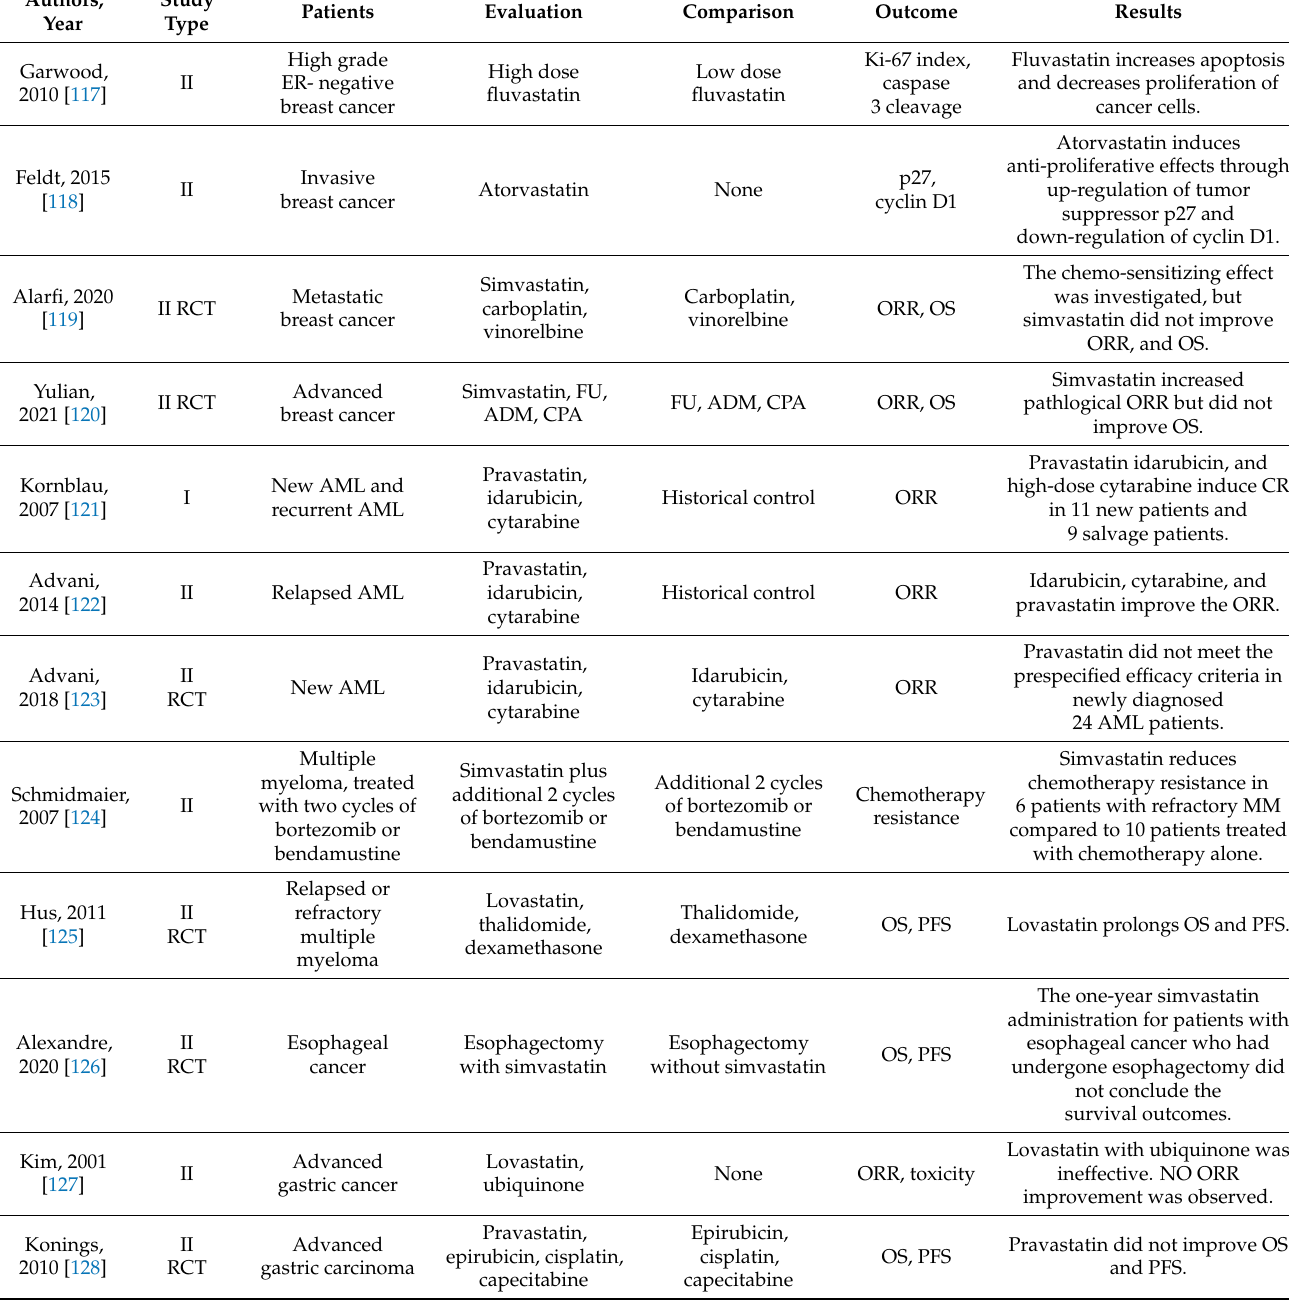
Table 3. Clinical studies of statin use for patients with malignant